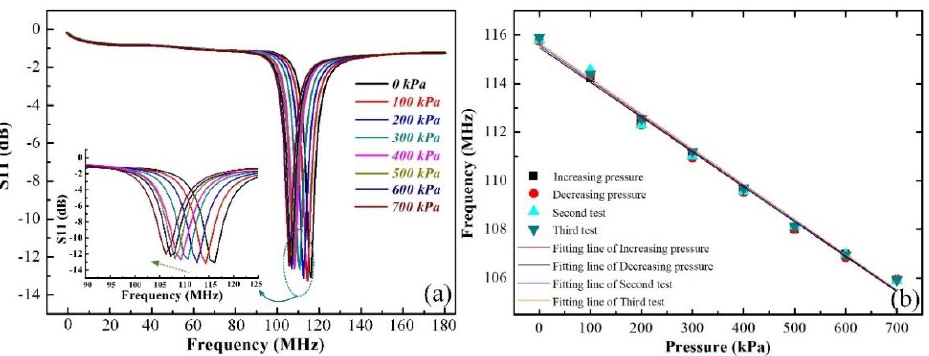
Figure 6. Pressure test results of the proposed sensor at room temperature. ( a ) The pressure versus resonant frequency curve under 0 kPa–700 kPa. ( b ) The frequency responses to pressure during the pressure increasing and decreasing process.